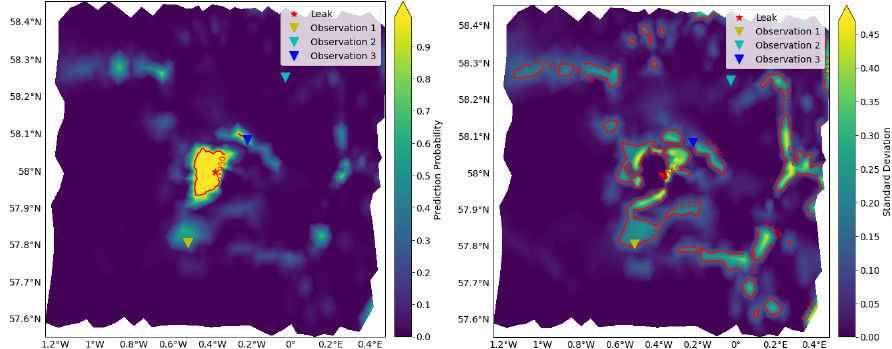
Figure 8. Prediction from the BCNN on the 3000T test data. ( Left panel ) The plot shows the predictive mean leak probability of the 1736 nodes with 200 forward MC realization on each instance. The red line shows where the predictive mean leak probability is above a value of 0.95. ( Right panel ) The plot shows the uncertainty in the prediction. Red line shows where the standard deviation is above 0.15 indicating areas where the prediction is uncertain. See Figure 9 for more details about the uncertainty in observation locations 1, 2, and 3.